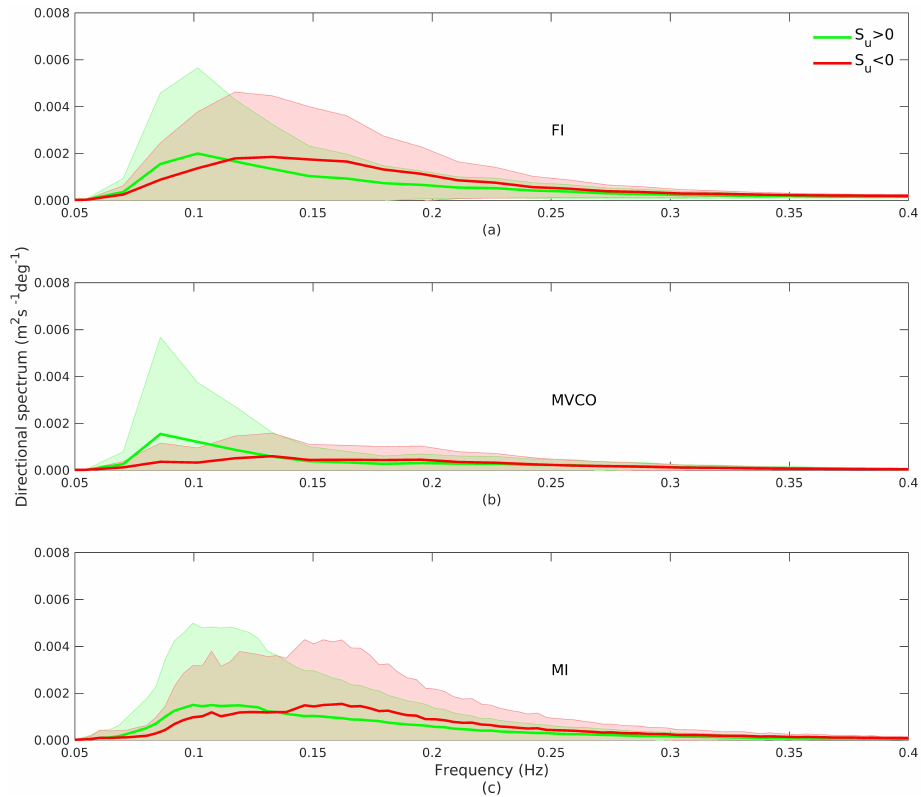
(cid:0)(cid:10) (cid:11)(cid:1) D spec − ω for the three sites